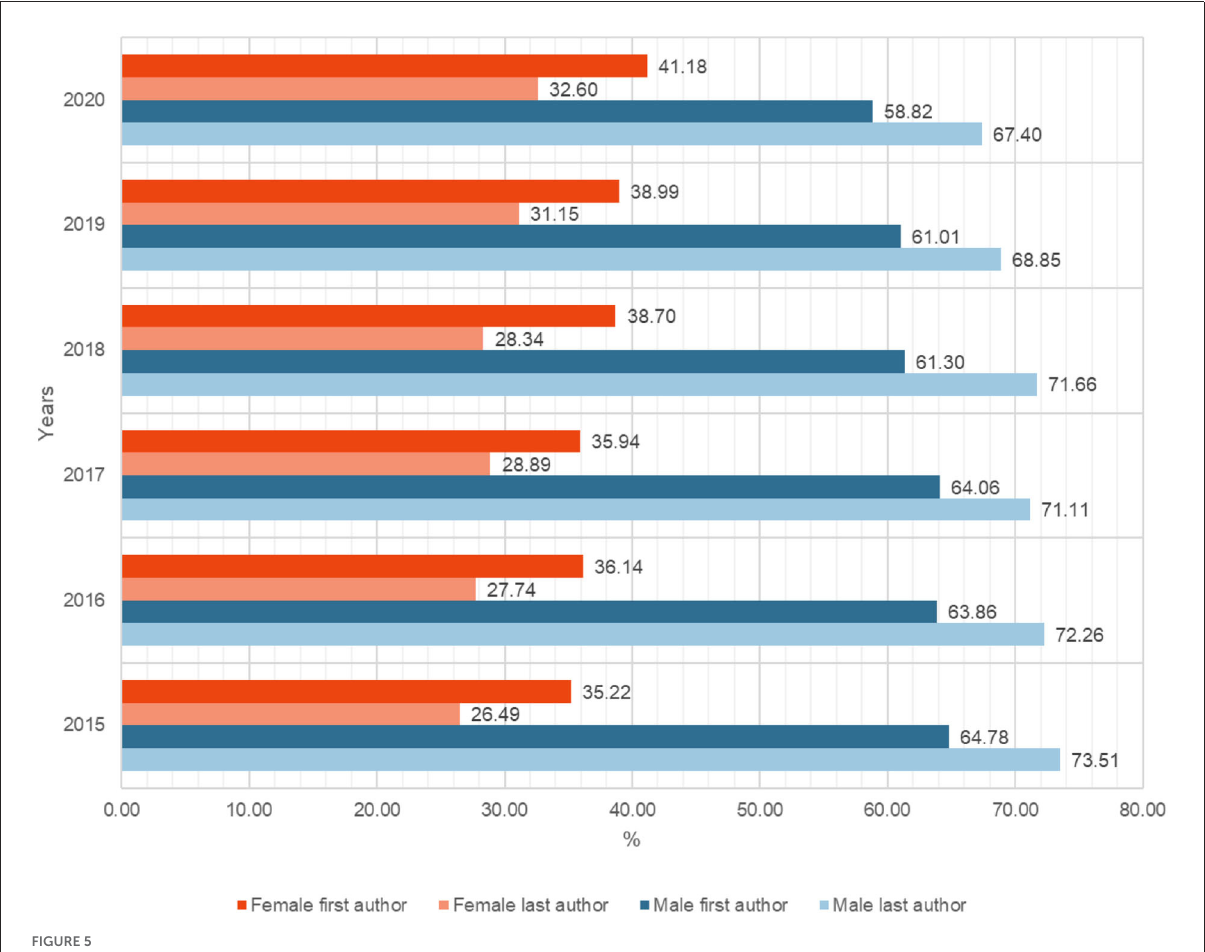
FIGURE5 Percentage of women and men in the first and last position of a